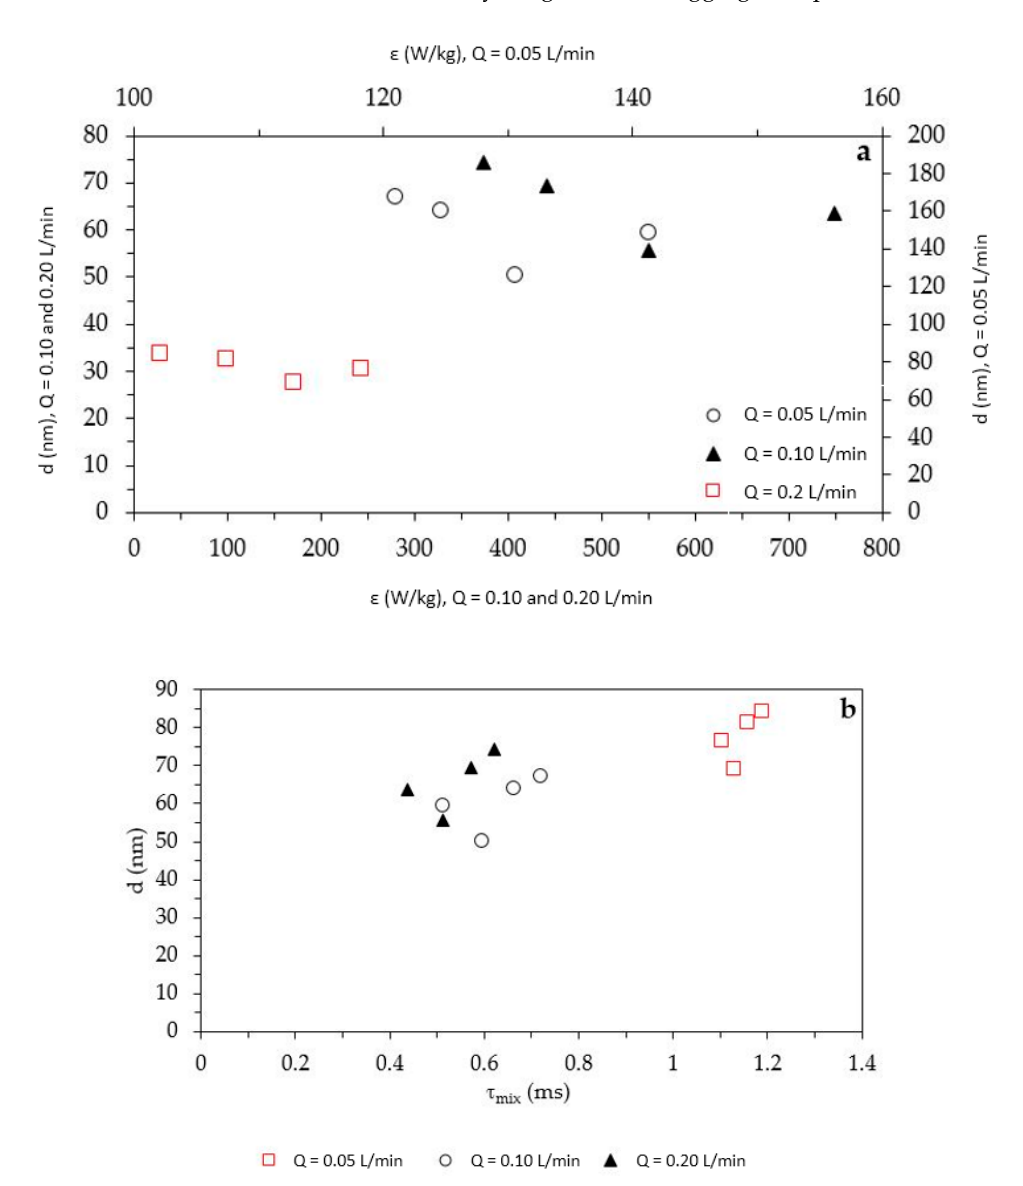
ε ( a ) and τ mix ( b